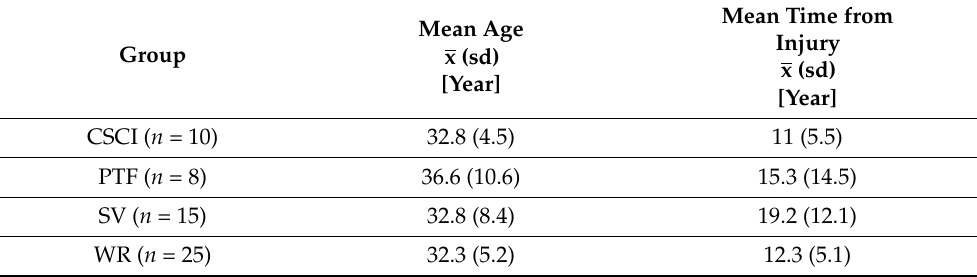
Table 1. Characteristics of the